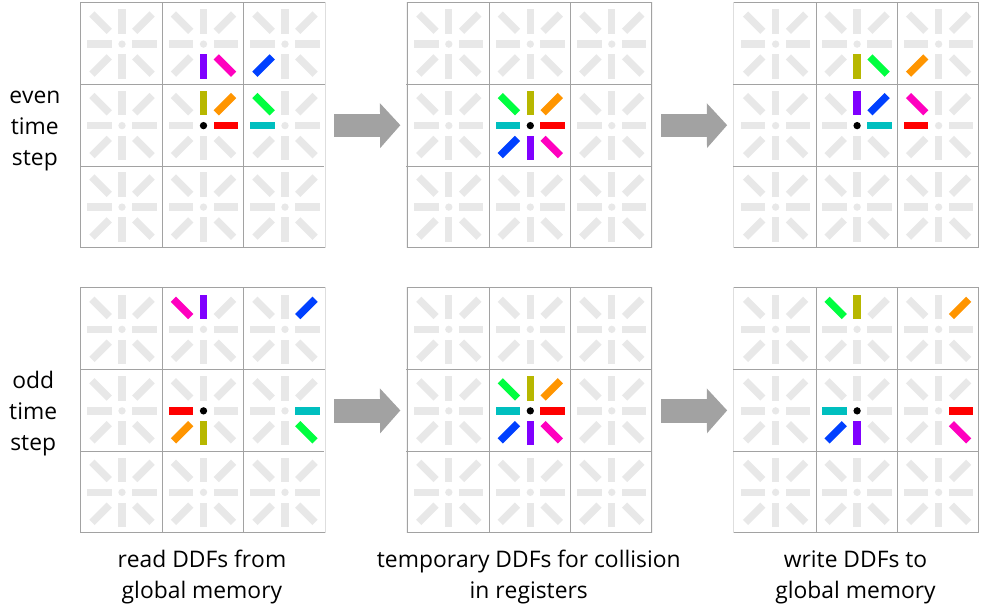
Figure 4. Esoteric Twist in-place streaming scheme [2]. Even time steps: DDFs are loaded in a criss-cross pattern shifted north-east by half a node. After collision, DDFs are stored in the same pattern but in opposite orientation. Odd time steps: DDFs are loaded in opposite orientation in a shifted criss-cross pattern that covers only DDFs not touched in the even time step. After collision, DDFs are written back in the same pattern but with regular orientation once again. DDFs are always stored in the same memory locations where they were loaded from, so only one copy of the DDFs is